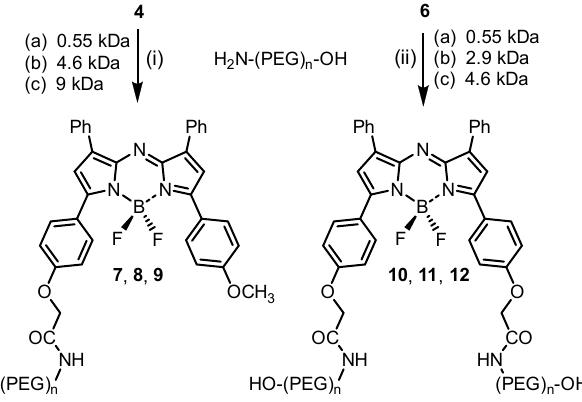
Figure 2. Representative partial 1 H NMR analysis for the conversion of 3 into 4 and subsequently into 7 . NMRs show chemical shift change in methylene and methoxy protons (coloured blue) as indicated in the structures. * PEG polymer.